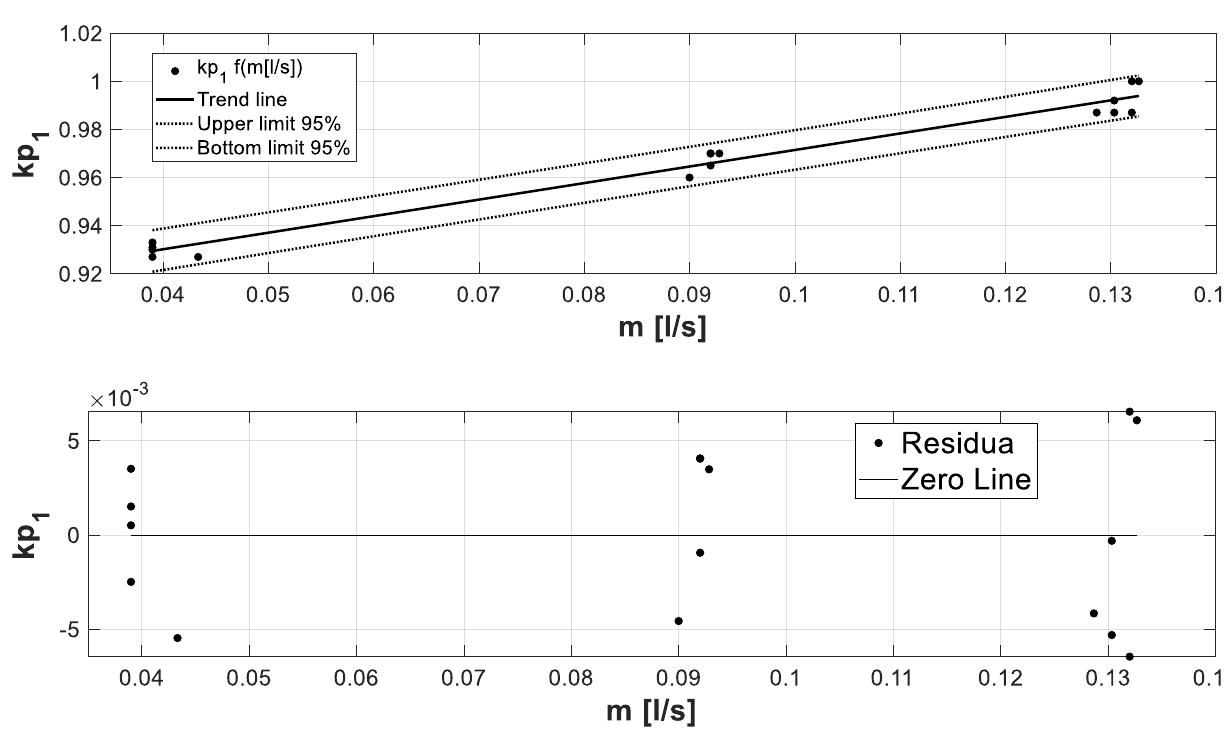
Figure 11. Impact of the circulator pump output on the value of the gain factor of the main path.